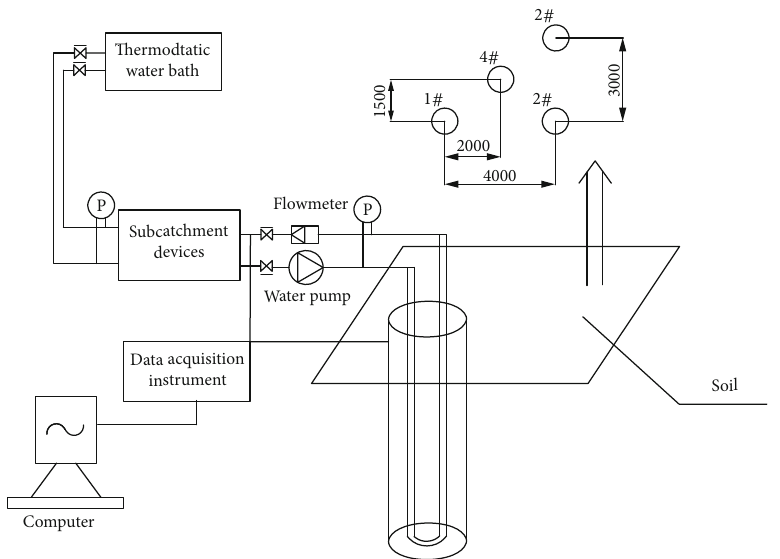
Figure 2: Schematic diagram of the experimental system.